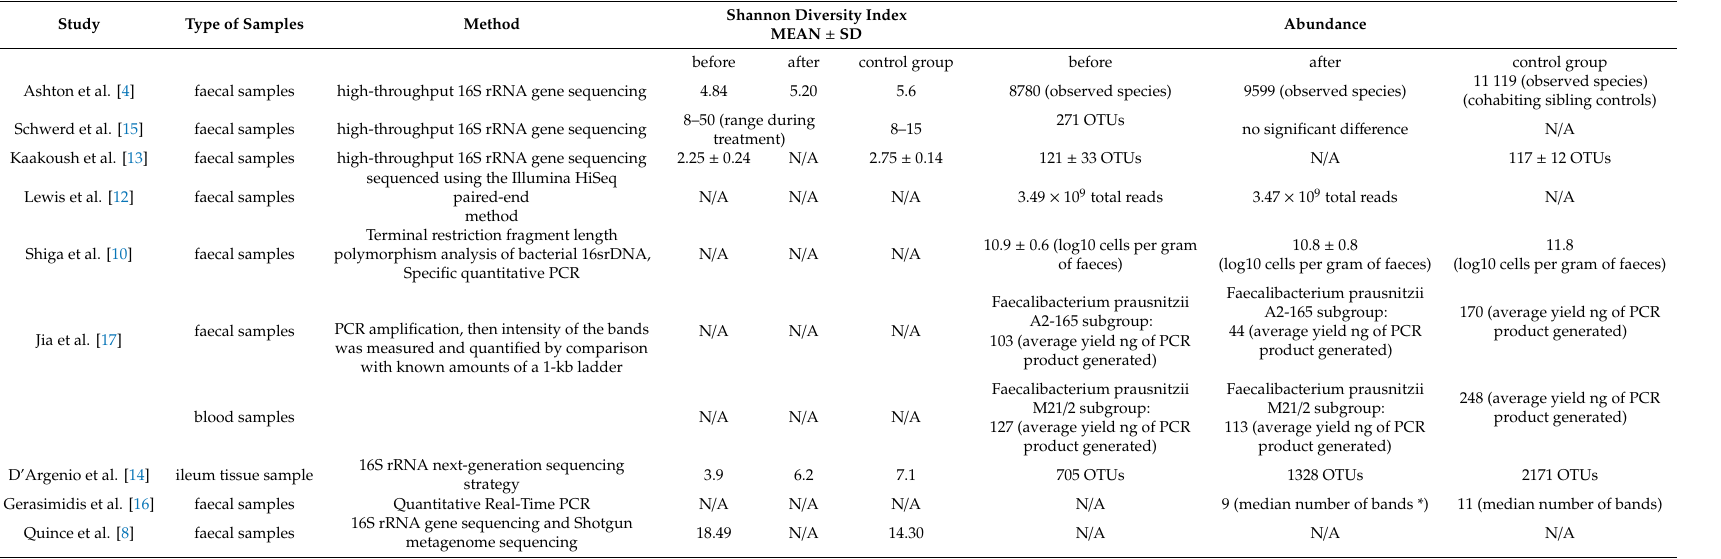
Table 3. Microbiome assessment and